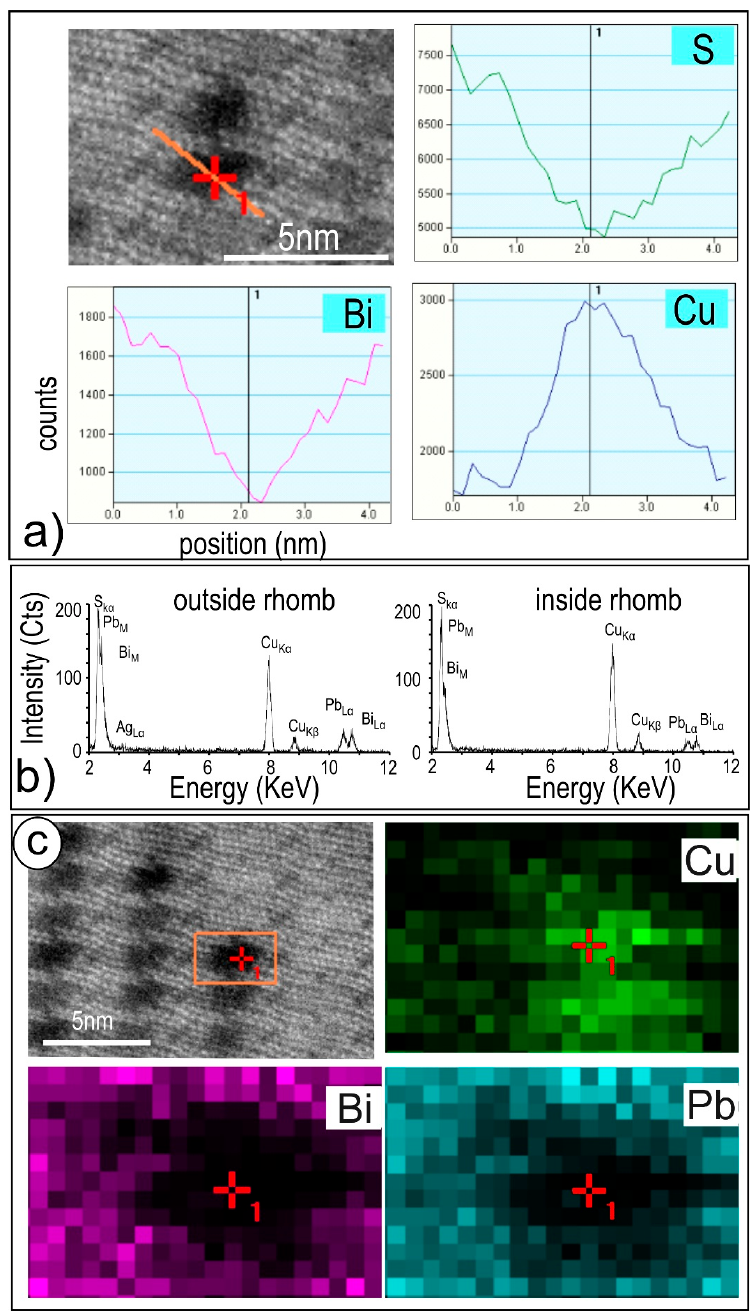
Figure 11. ( a ) EDS profile across one of the dark ‘rhombic’ motifs showing that it is richer in Cu; ( b ) EDS spectra for points along the profile in ( a ), showing the relative variation in concentrations of the main elements for spots outside and inside the motif. The high Cu peak is due to interference with the Cu grid. Note that the Ag peak is barely visible for neyite (concentration threshold for the detector?); ( c ) EDS elemental maps for one of rhombic motifs (rectangle on HAADF STEM image corner left), showing that it is Cu-rich, and Bi-Pb-poor relative to the enclosing matrix.